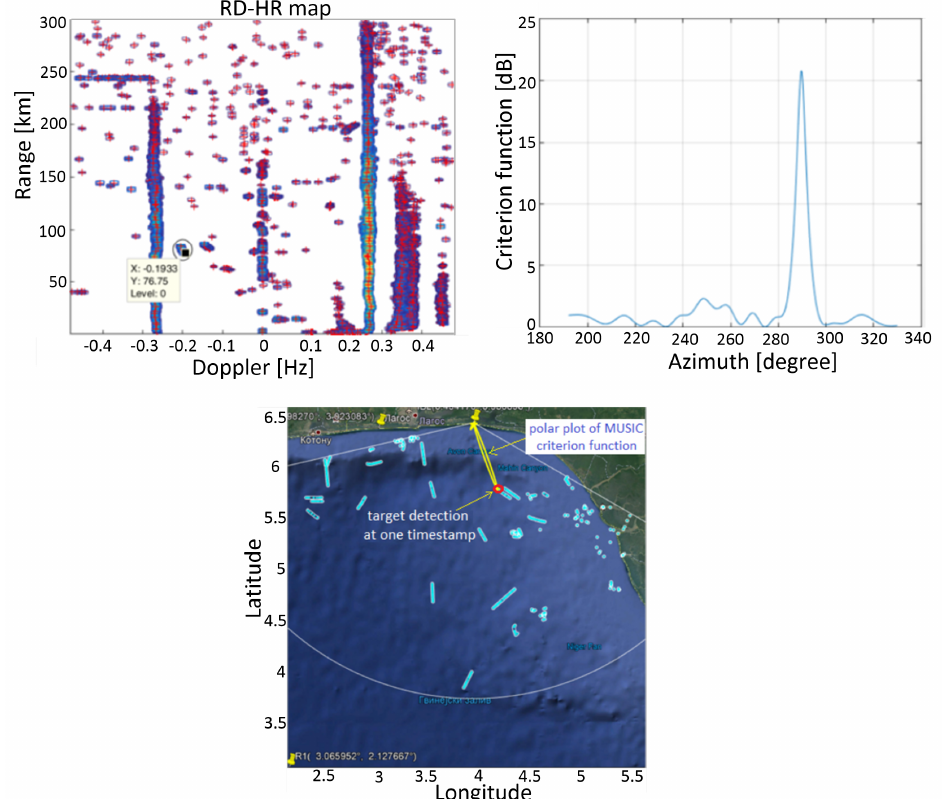
Figure 16. Detection of a vessel using the proposed algorithm: Detections in RD-HR map denoted by ”+” markers ( upper left ), Azimuth estimation (A-HR criterion function) for the selected vessel detected in RD-HR map ( upper right ) and display of that detection (red circle) on a geographical map ( bottom ) with AIS data as a benchmark (light blue tracks), where the A-HR function is drawn as a yellow line (in polar coordinates, with the origin at the radar station) and scaled so that its maximum is at the position of the